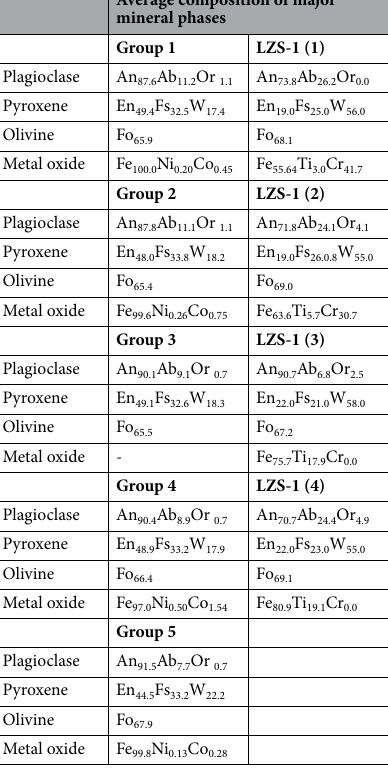
Average composition of major mineral